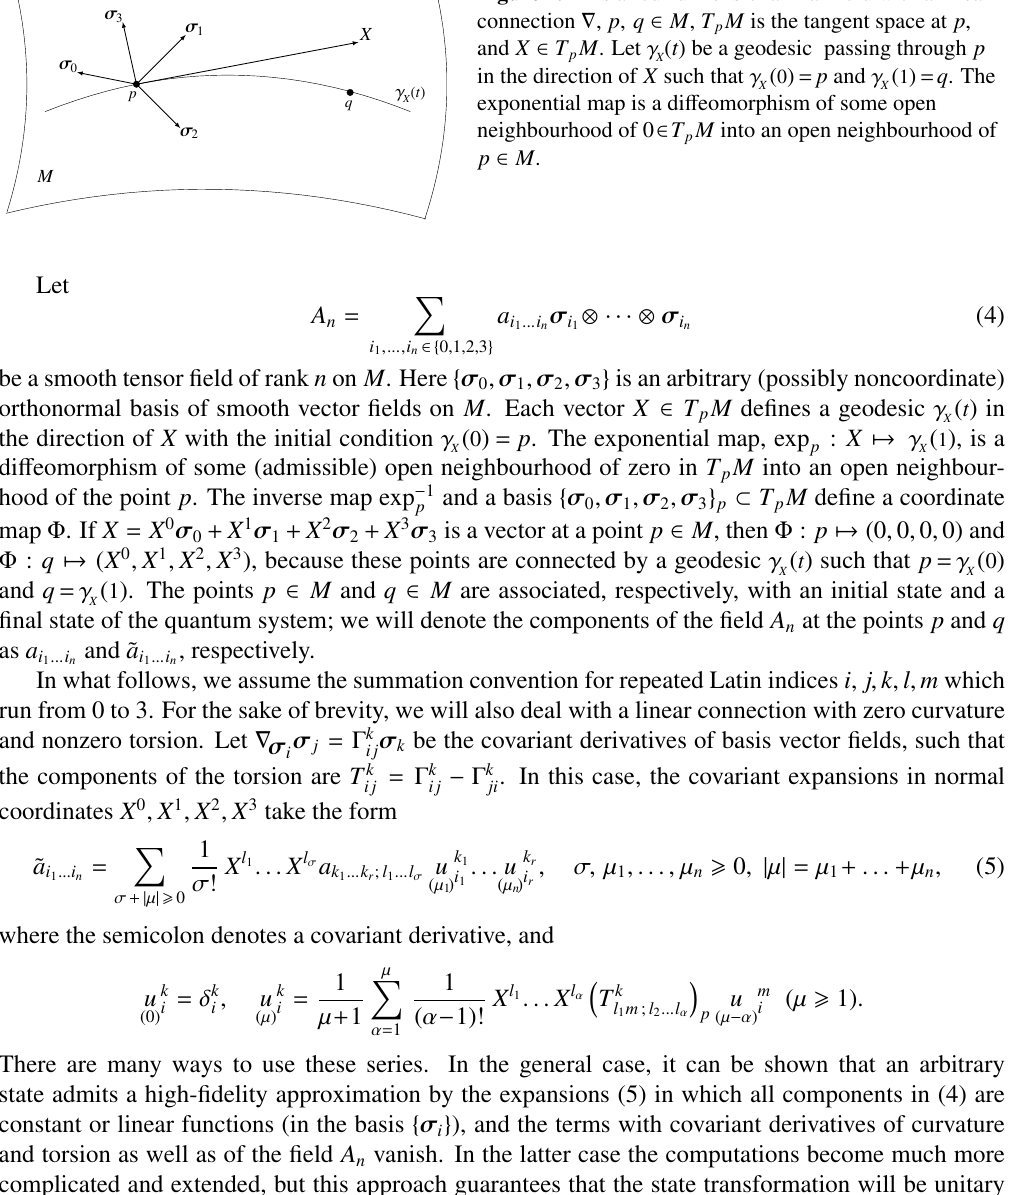
Figure 1. M is a four-dimensional manifold with a linear M , T p M is the tangent space at p , connection , p , q ∇ ∈ T p M . Let γ and X ( t ) be a geodesic passing through p X ∈ in the direction of X such that γ ( 0 ) = p and γ ( 1 ) = q . The X X exponential map is a di ff eomorphism of some open T p M into an open neighbourhood of neighbourhood of 0 ∈ p M ∈